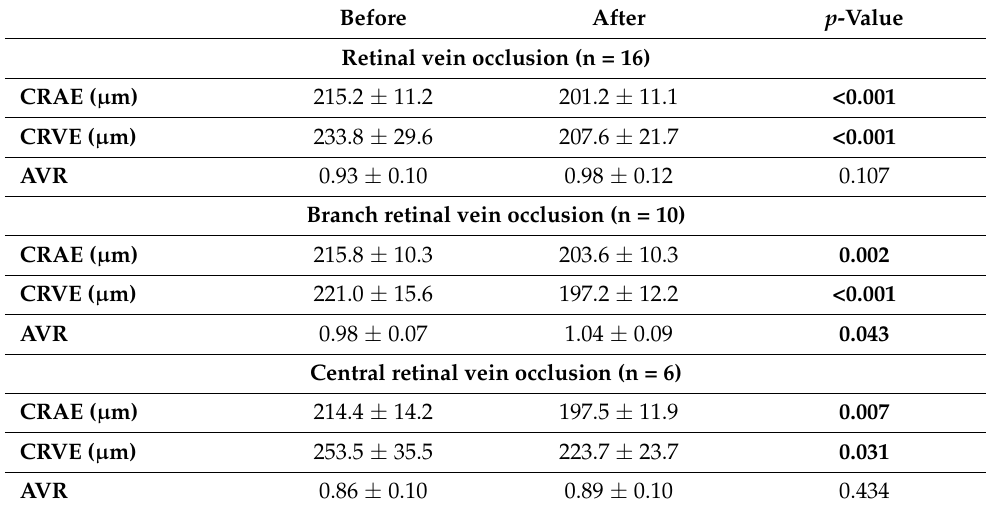
Table 2. Retinal vessel diameters before and after intravitreal ranibizumab treatment in RVO patients. Before After p